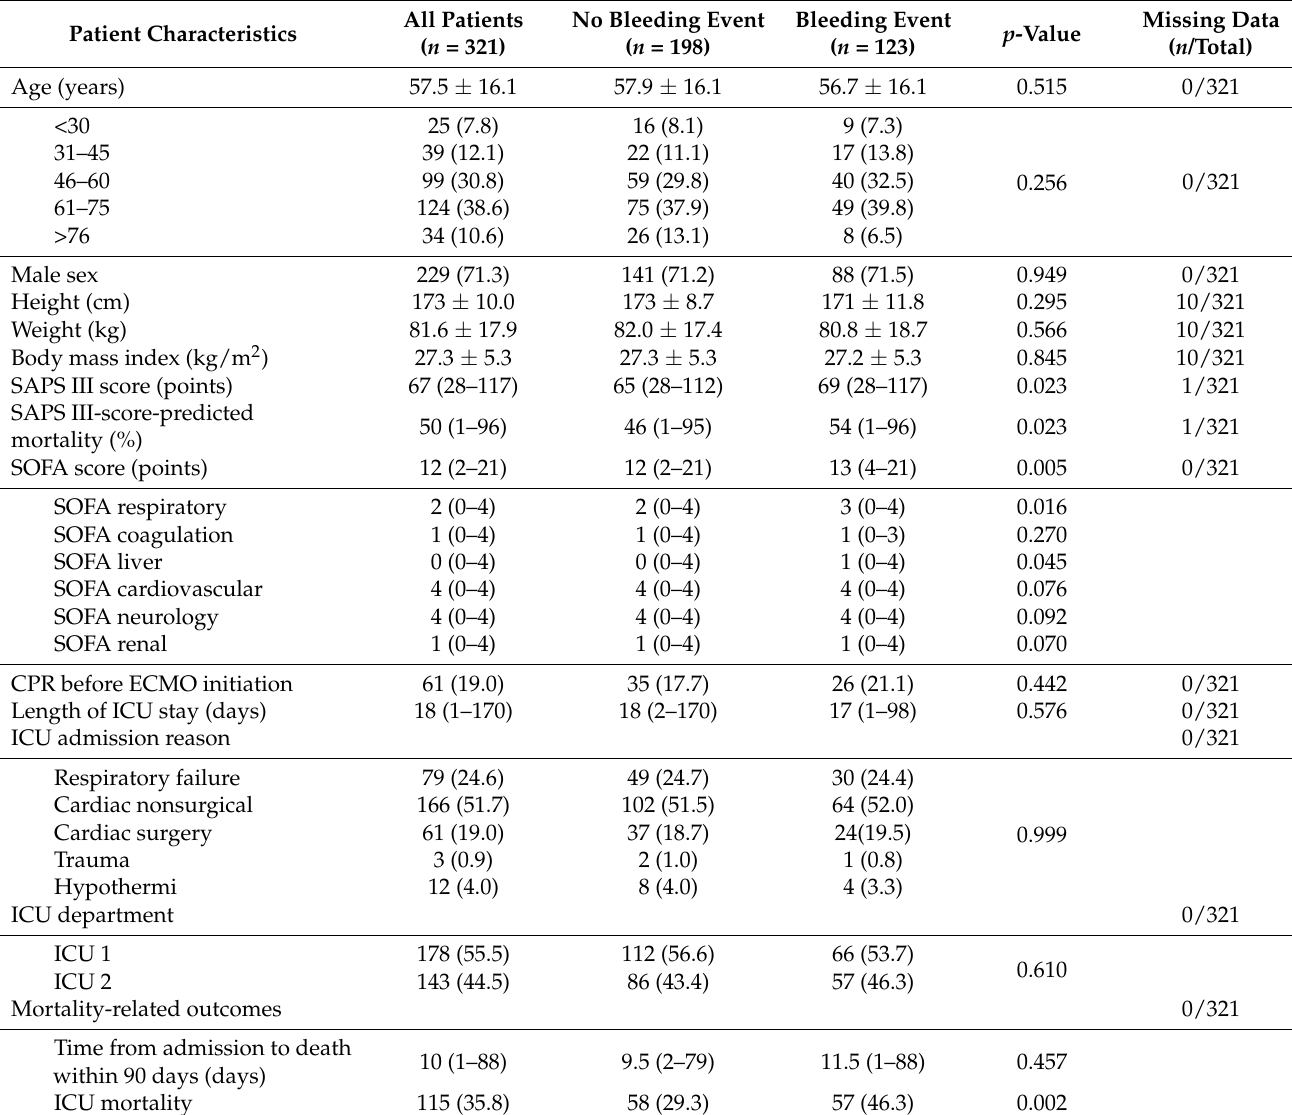
Table 1. Extracorporeal membrane oxygenation: patient demographic and clinical characteristics ( n =